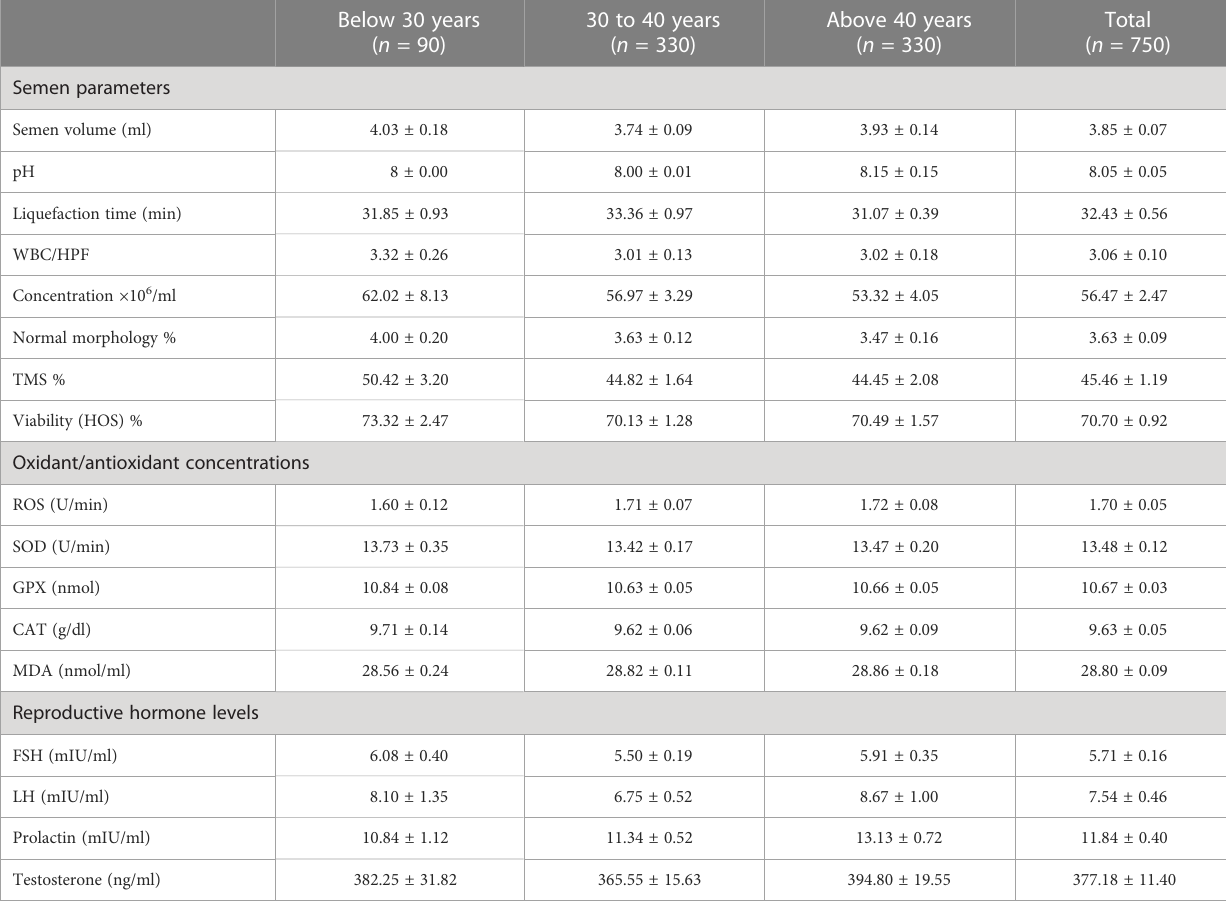
TABLE 2 The effects of male age on semen parameters, biochemical pro fi le, and reproductive hormone concentration in studied